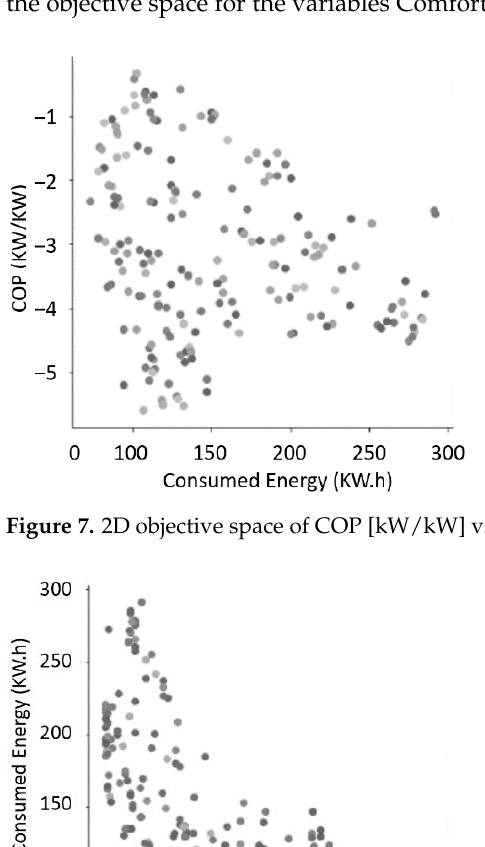
Figure 9. 2D objective space of COP [kW/kW] vs. Comfort [°C]. Metrics used in the comparison were computed with the JMetal framework, and the ETs were recorded. The SPEA2 algorithm was dropped from the analysis, as it takes 22- fold more runtime than MOGA [45]. Figure 10 shows the obtained ET values.